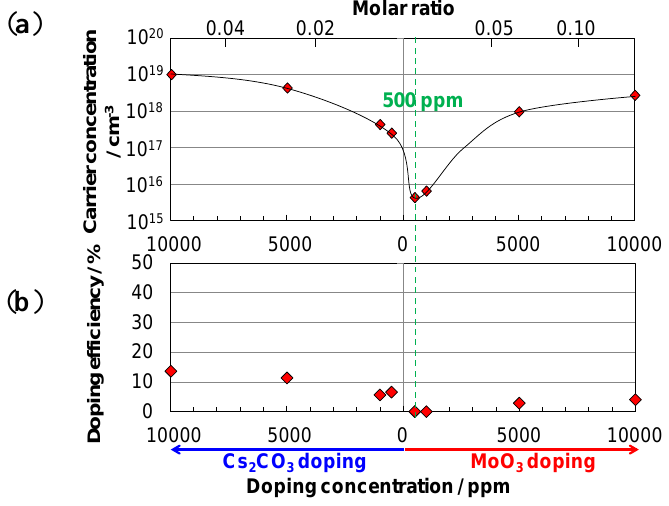
CO or MoO 2 3 3